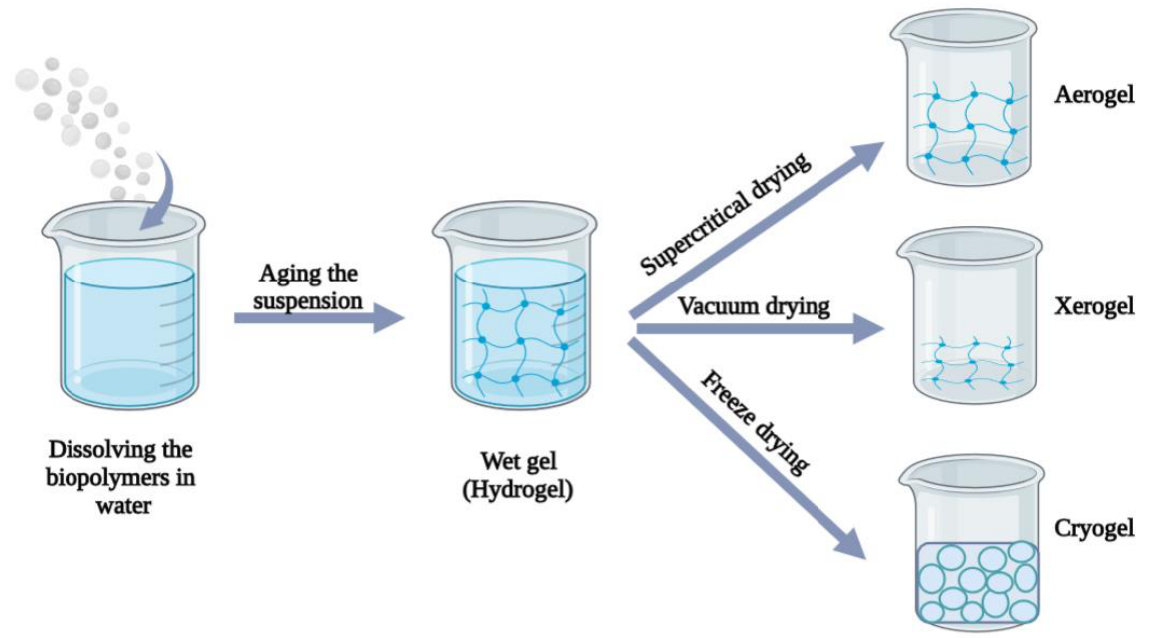
Figure 3. Schematic illustration of the preparation of aerogels, xerogels and cryogels from hydrogels (image created using the BioRender application; https://app.biorender.com).